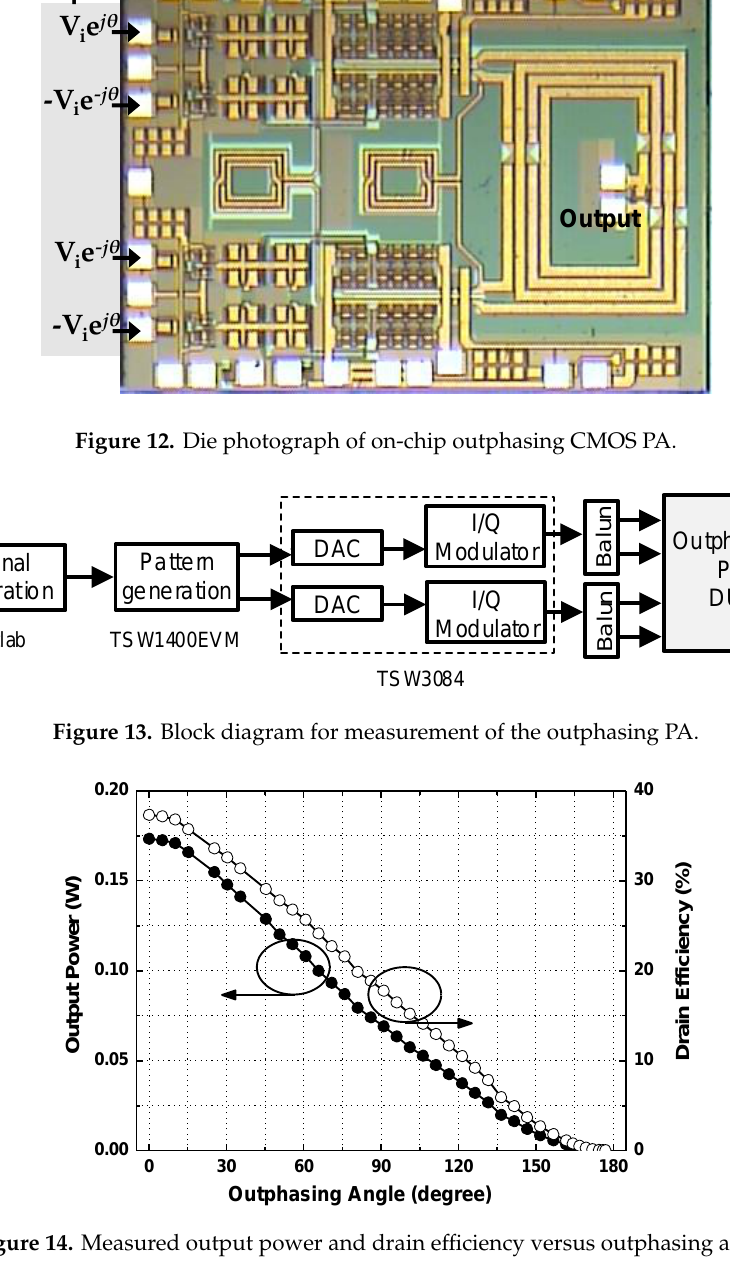
Figure 14. Measured output power and drain efficiency versus outphasing angle.